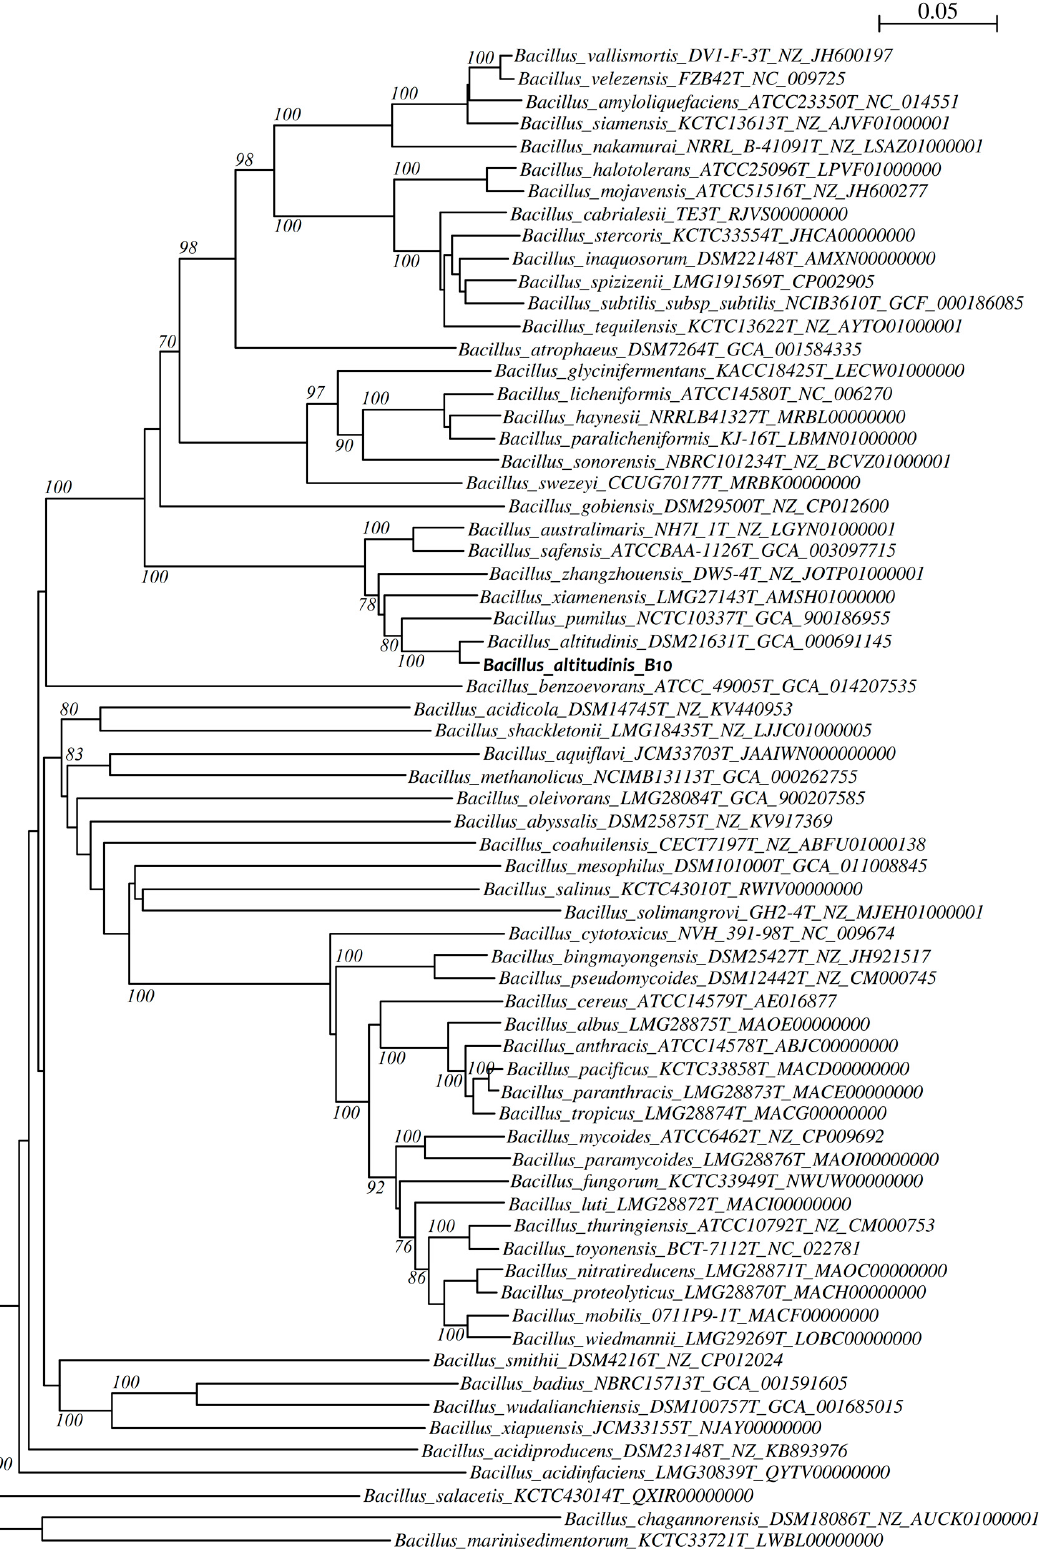
Figure 6. Neighbor-joining phylogenetic tree based on gyrB gene sequences showing the positions of the B10 isolate B. altitudinis and the type strains of the genus Bacillus. Bootstrap values >70 are shown above branches. Bar: 0.05 substitutions per nucleotide position. Sequence accession numbers are given following strain